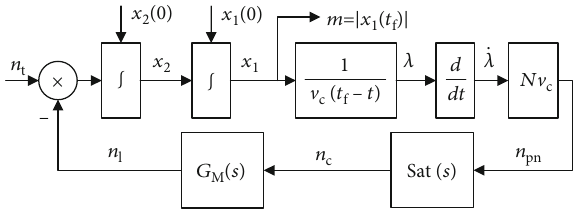
Figure 5: Block diagram of the numeric derivative terminal guidance system.